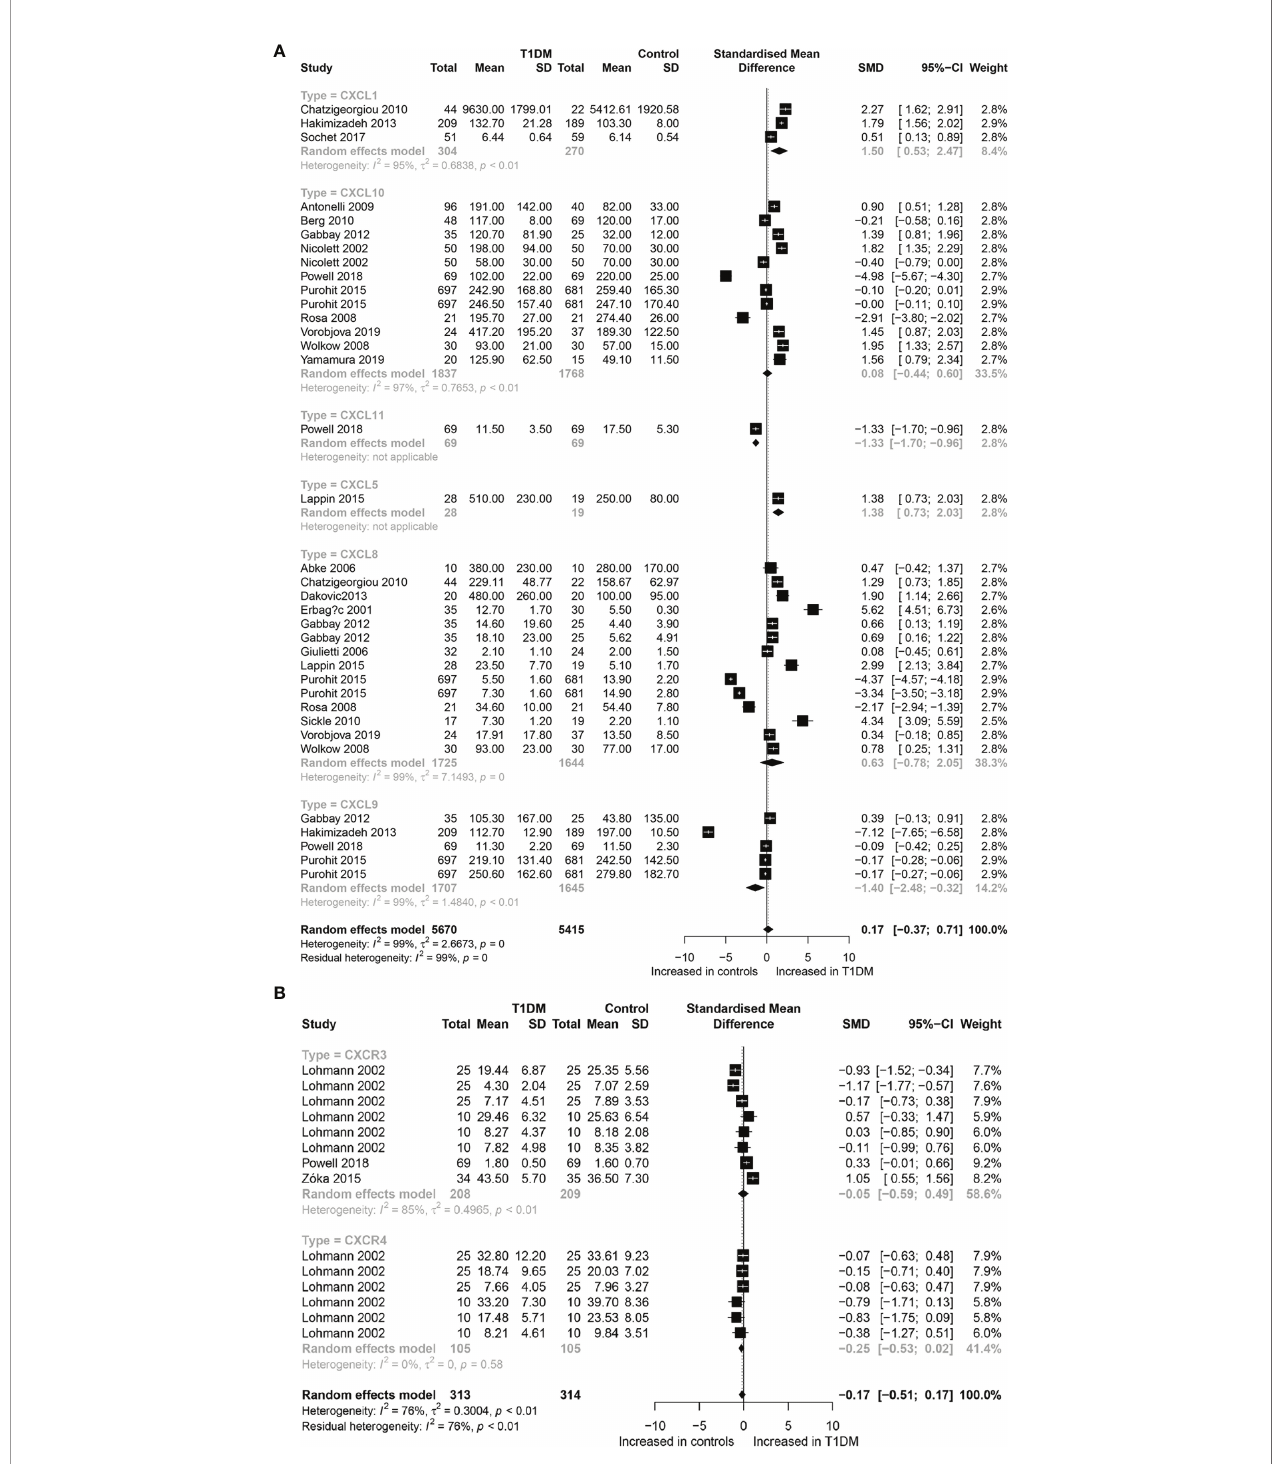
FIGURE 2 | Forest plot of CXC chemokines (A) and CXCR (B) between T1DM patients and controls. Study effect sizes of chemokines differences between T1DM and controls. Each data marker represents a study, and the size of the data marker is proportional to the total number of individuals in that study. The summary effect size for each chemokines is denoted by a diamond; T1DM, Type 1 diabetes mellitus; CXCR, CXC chemokines receptor; SMD, standardized mean